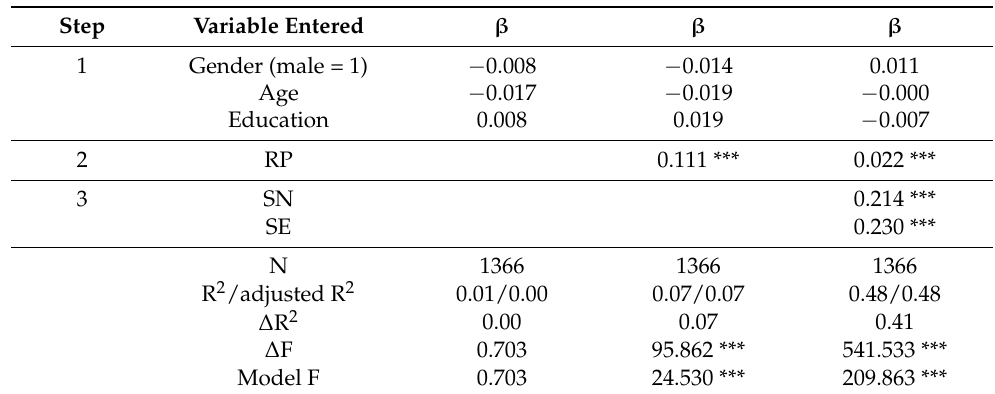
Table 1. Multiple linear regression of intention to use sports apps.